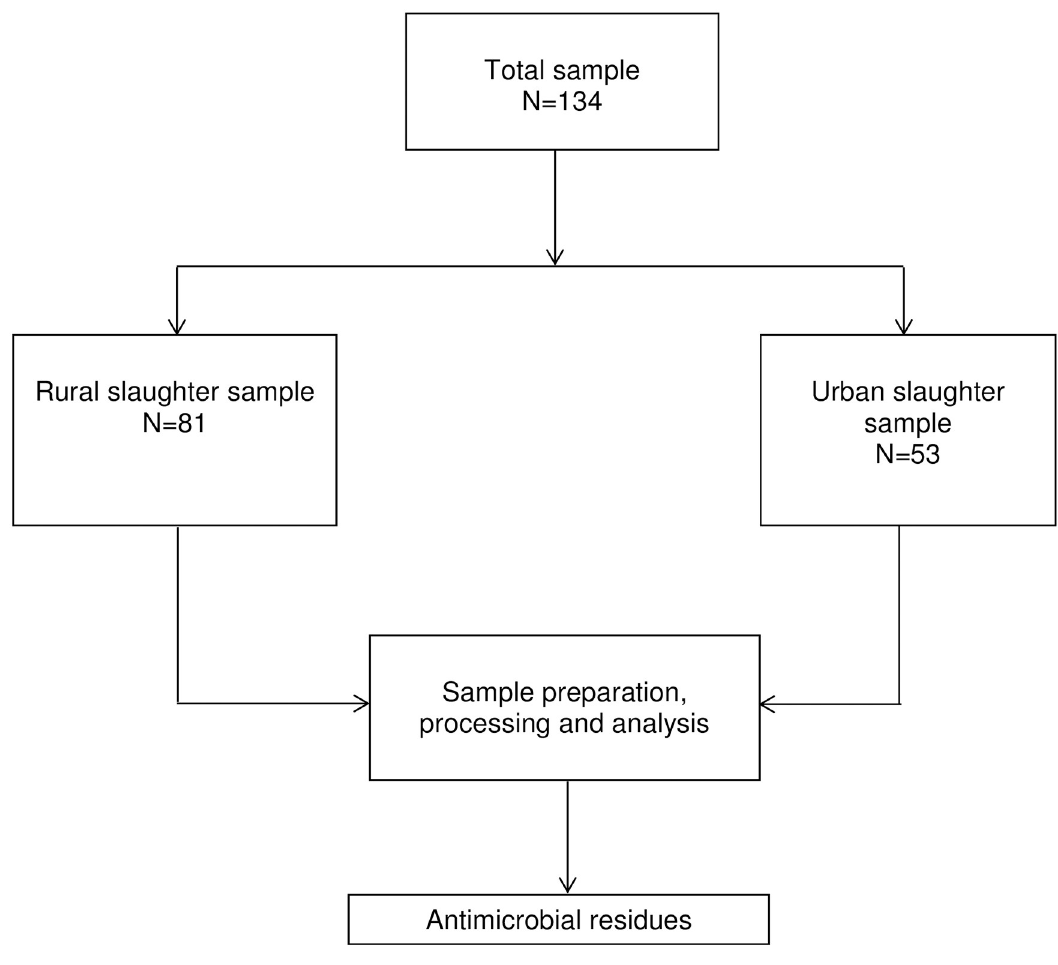
Fig 1. Flow chart of tissue